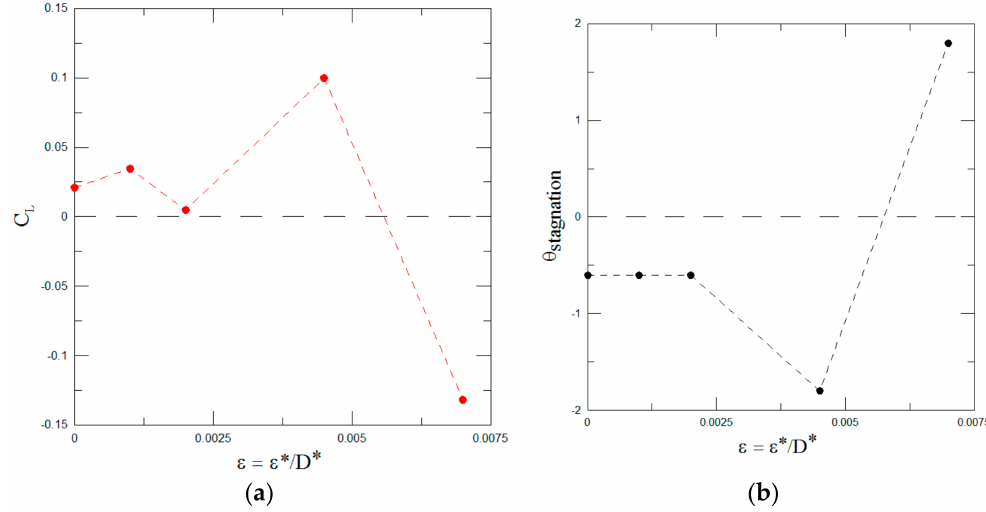
Figure9. Separationbubbleidentification(Re = 1.0 × 10 5 ): ( a )Meanliftcoe ffi cient; ( b